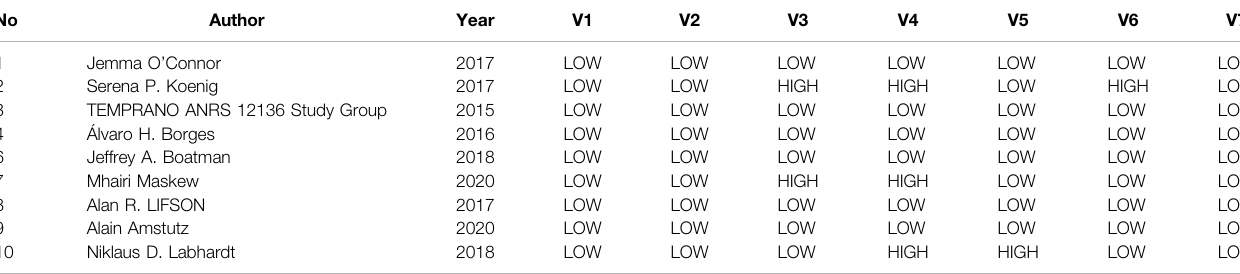
TABLE 2 | Assessment of risk of bias in the included literature. No